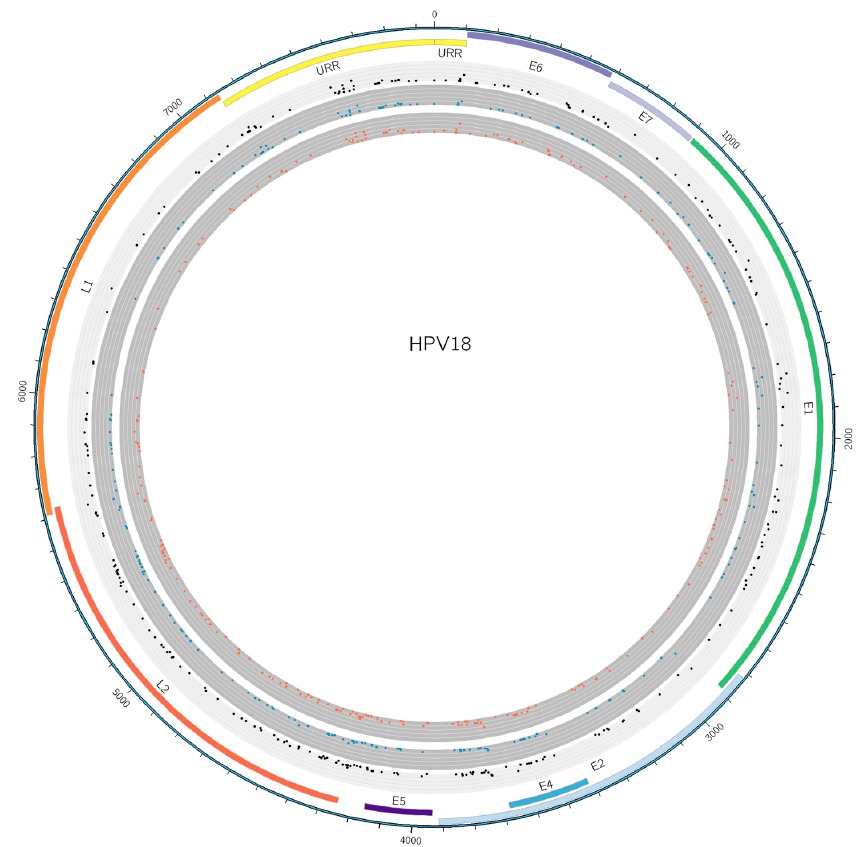
Figure 3. Circular plot of non-orphan single-nucleotide polymorphisms (SNPs) on the human papillomavirus (HPV) 18 genome. Each dot denotes a variable site within the dataset. Black dots show total SNPs occurring in this study. Blue dots were variations identified in clearing infections, while reds dots were variations identified in persisting infections. Total DNA variations are shown on the light grey circles. Height of dots on the respective circles shows how often the variation occurs in the dataset.